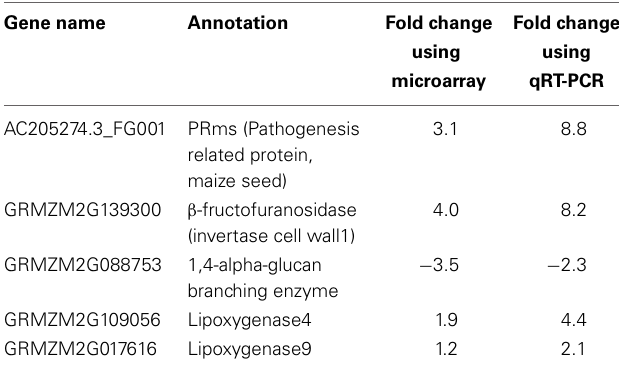
Table 3 | qRT-PCR results for select differentially expressed genes are consistent with microarray